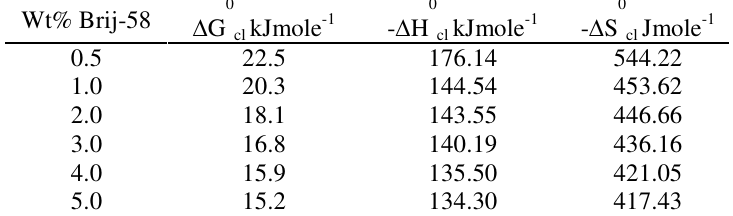
Table 8. Thermodynamic parameter of Brij-58/methionine